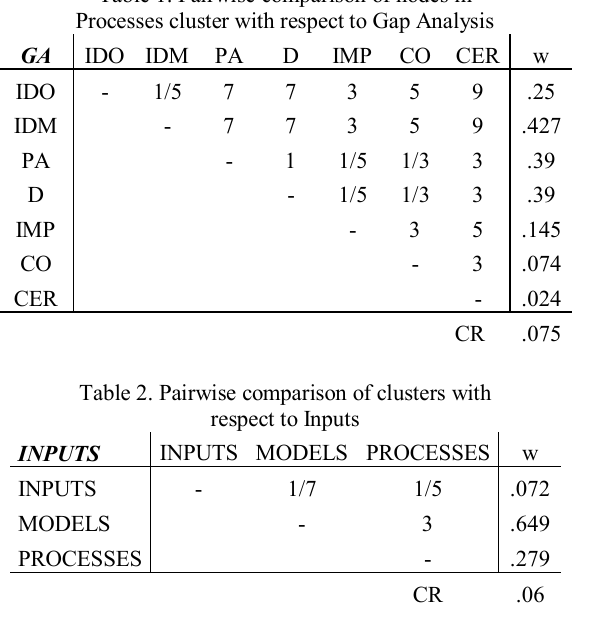
Table 1. Pairwise comparison of nodes in